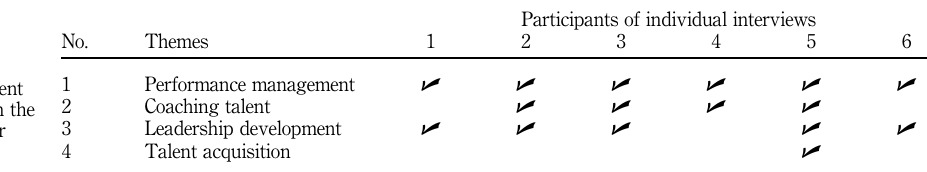
Table I. Talent development processes used in the Australian higher